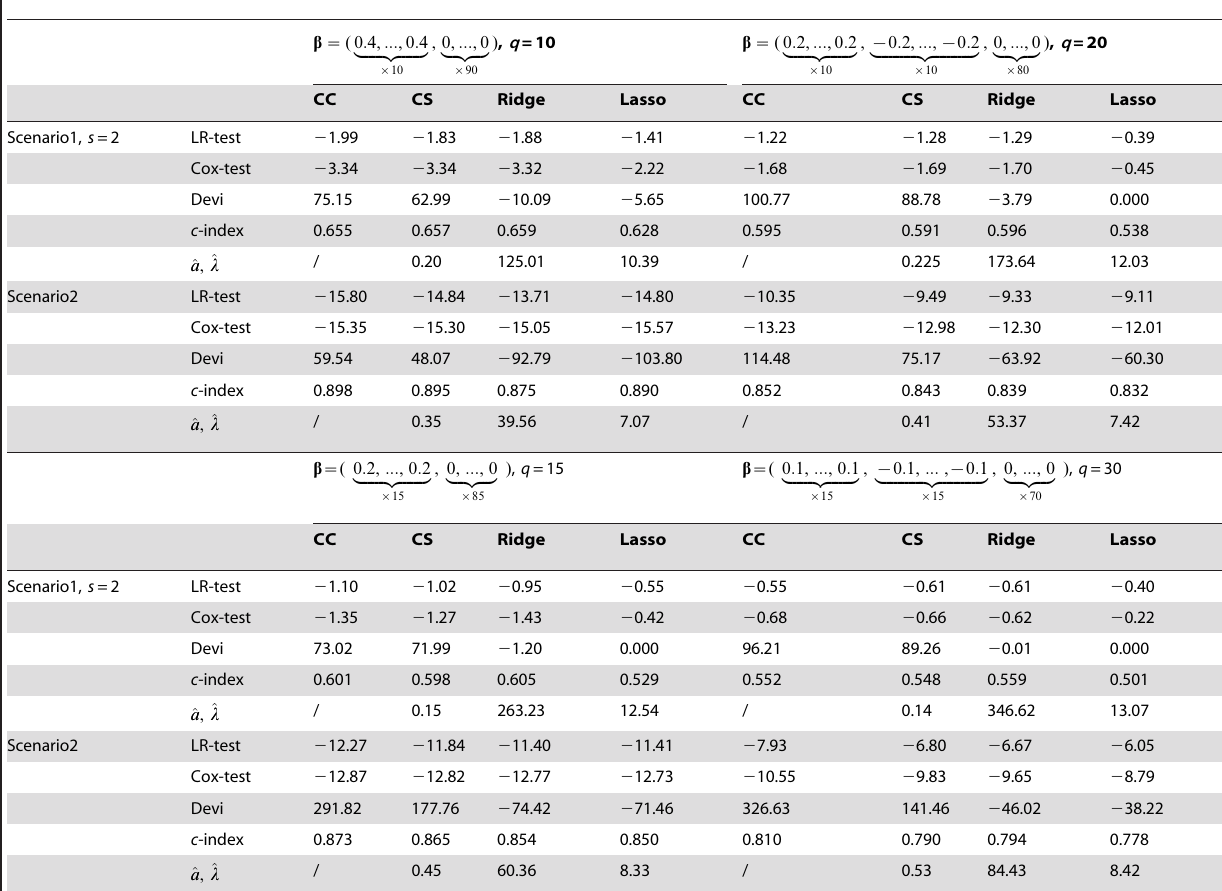
Table 2. Simulation results under less sparse cases with p =100 and n =100 based on 50 replications.